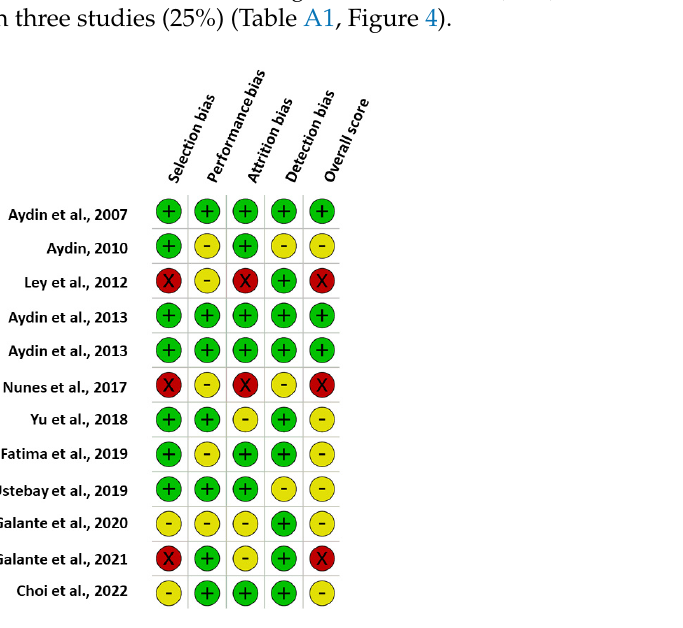
Figure 4. Risk of bias in studies assessing the relationship between concentrations of metabolic hormones in human milk and gestational diabetes mellitus using the National Institute for Clinical Excellence methodological checklist. “+, green,” low risk of bias; “×, red,” high risk of bias; “-, yellow,” unclear/medium risk of bias.